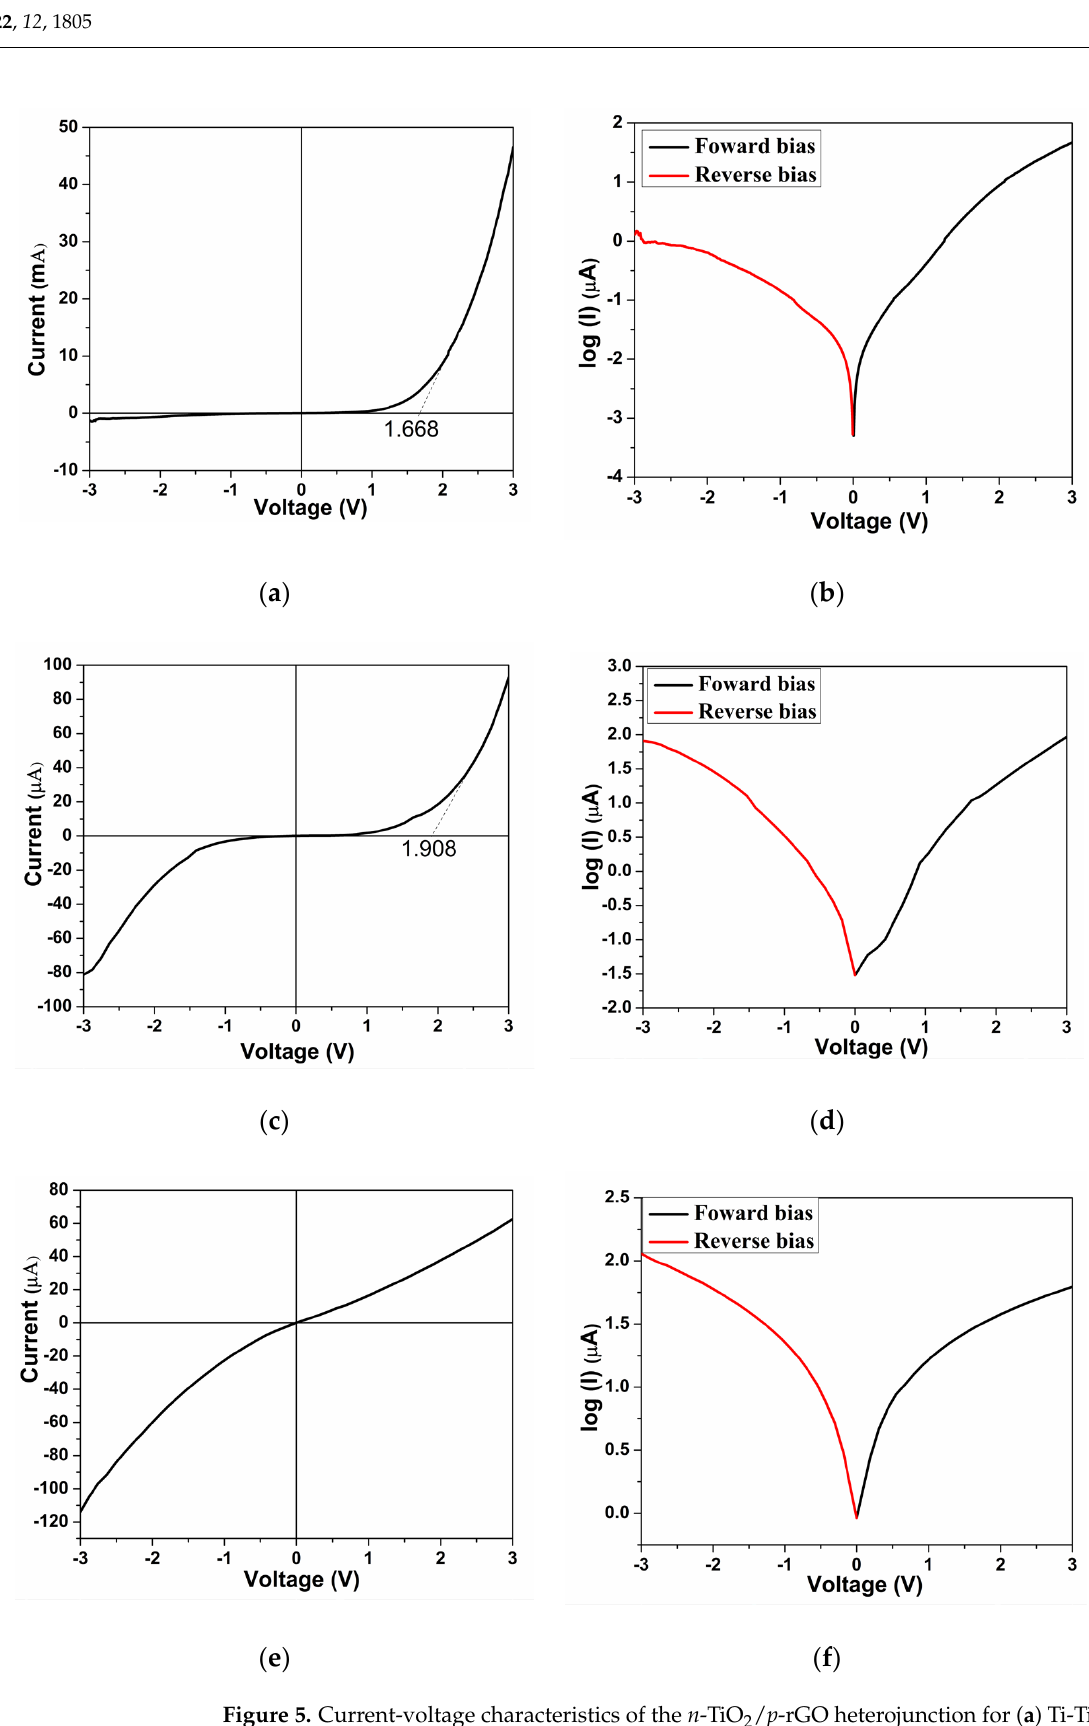
Figure 5. Current-voltage characteristics of the n -TiO 2 / p -rGO heterojunction for ( a ) Ti-TiO 2 -rGO-1h, ( c ) Ti-TiO 2 -rGO-2h, and ( e ) Ti-TiO 2 -rGO-3h; Log from forward and reverse bias for ( b ) Ti-TiO 2 -rGO-1h, ( d ) Ti-TiO 2 -rGO-2h, and ( f ) Ti-TiO 2 -rGO-3h. Figure 5b,d,f present a Log (I)–V between the forward and reverse biases of the composite structures. The rectifying nature of the TiO 2 /rGO heterojunction and an in- crease in the asymmetry between the forward and reverse biases is highlighted more for